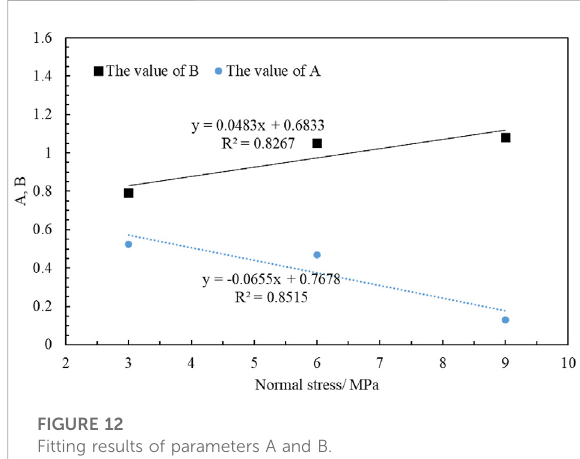
FIGURE 12 Fitting results of parameters A and